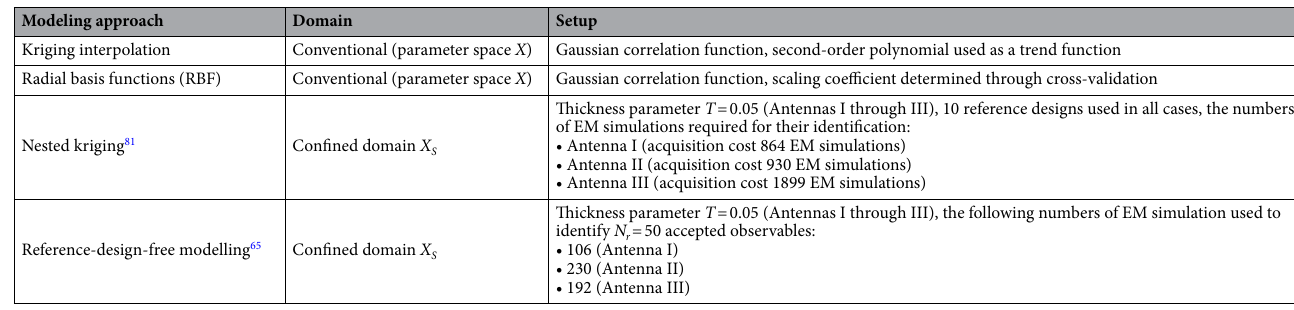
Table 2. Benchmark modeling